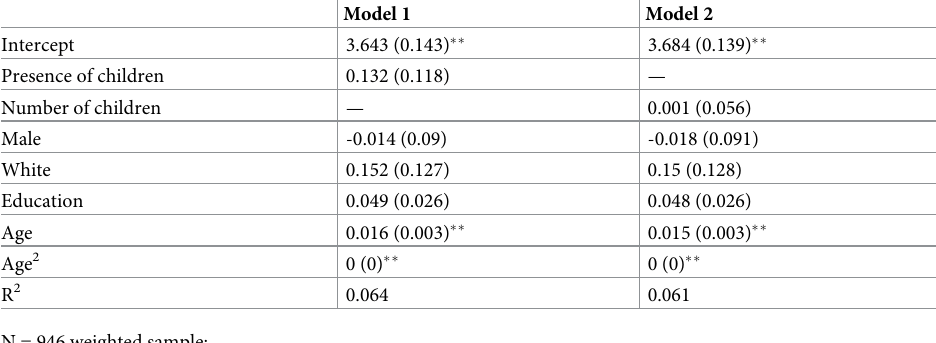
Table 2. Association of the presence or number of children and neighborhood satisfaction.